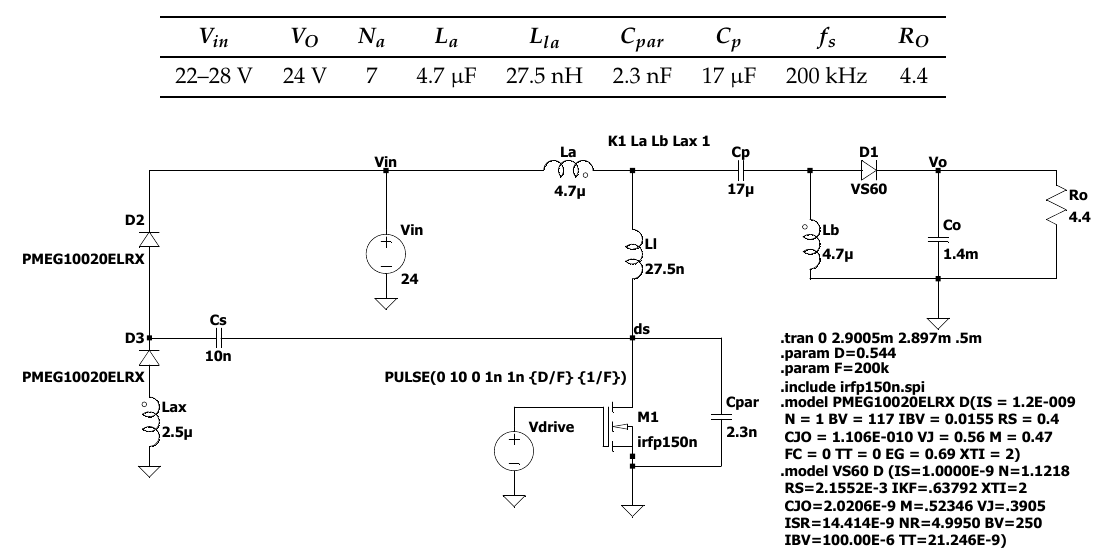
Table 1. Simulation and experimental parameters.